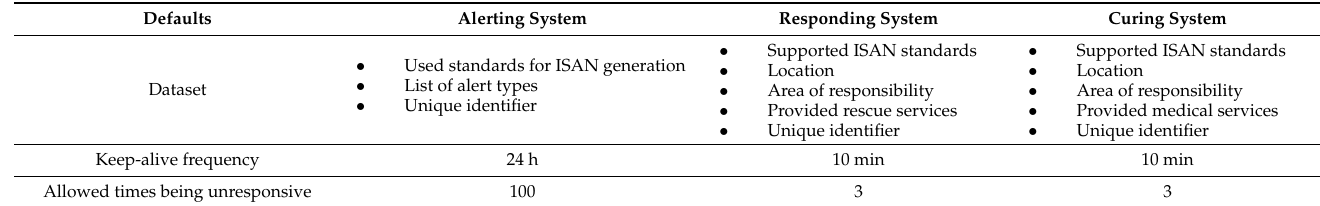
Table 1. Registration dataset for ICT